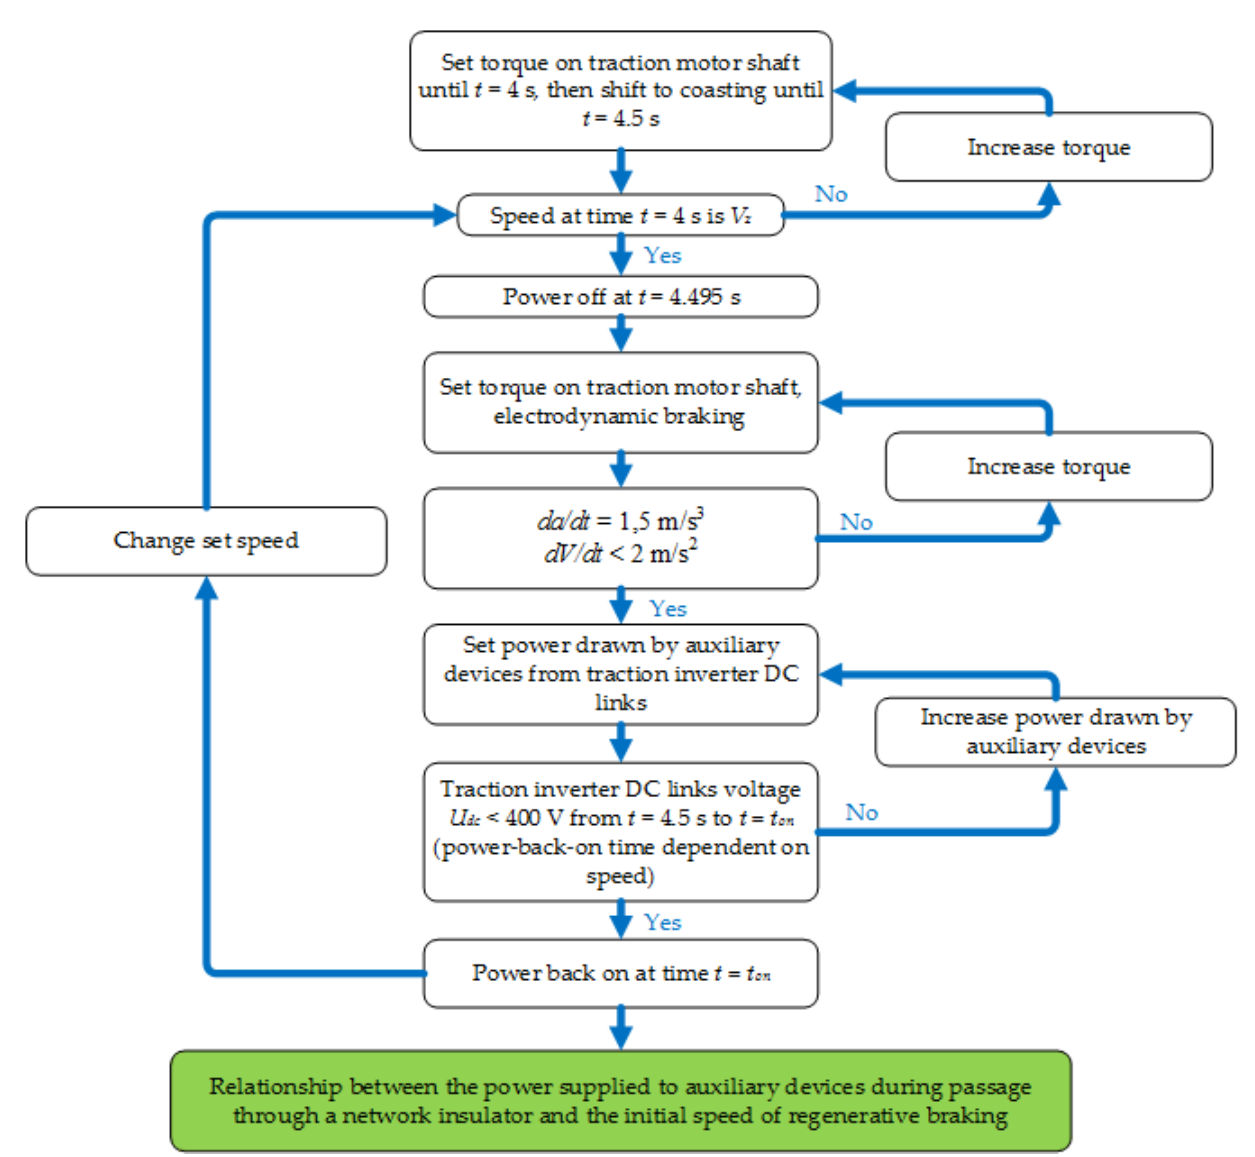
Figure 8. Simulation algorithm.